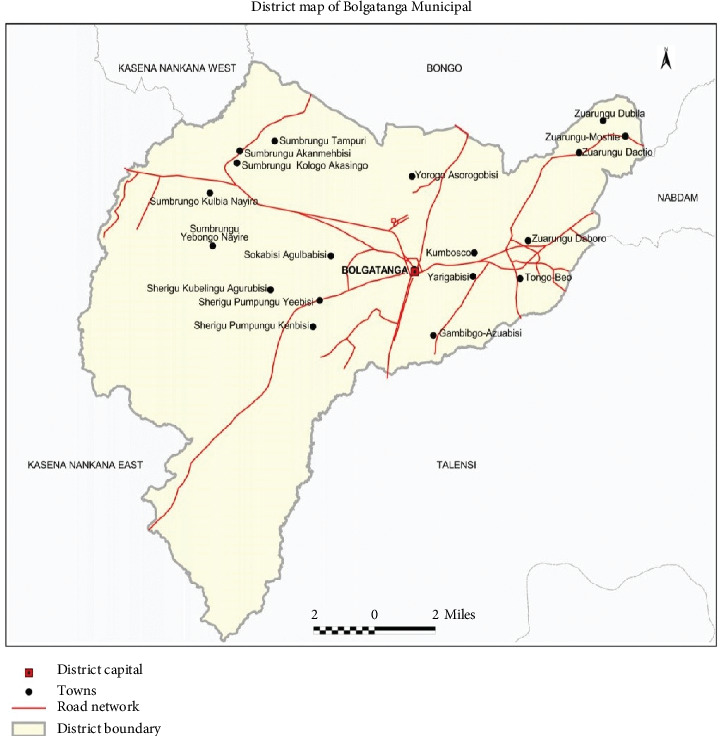
Map of Bolgatanga Municipal (source: GSS [11]).